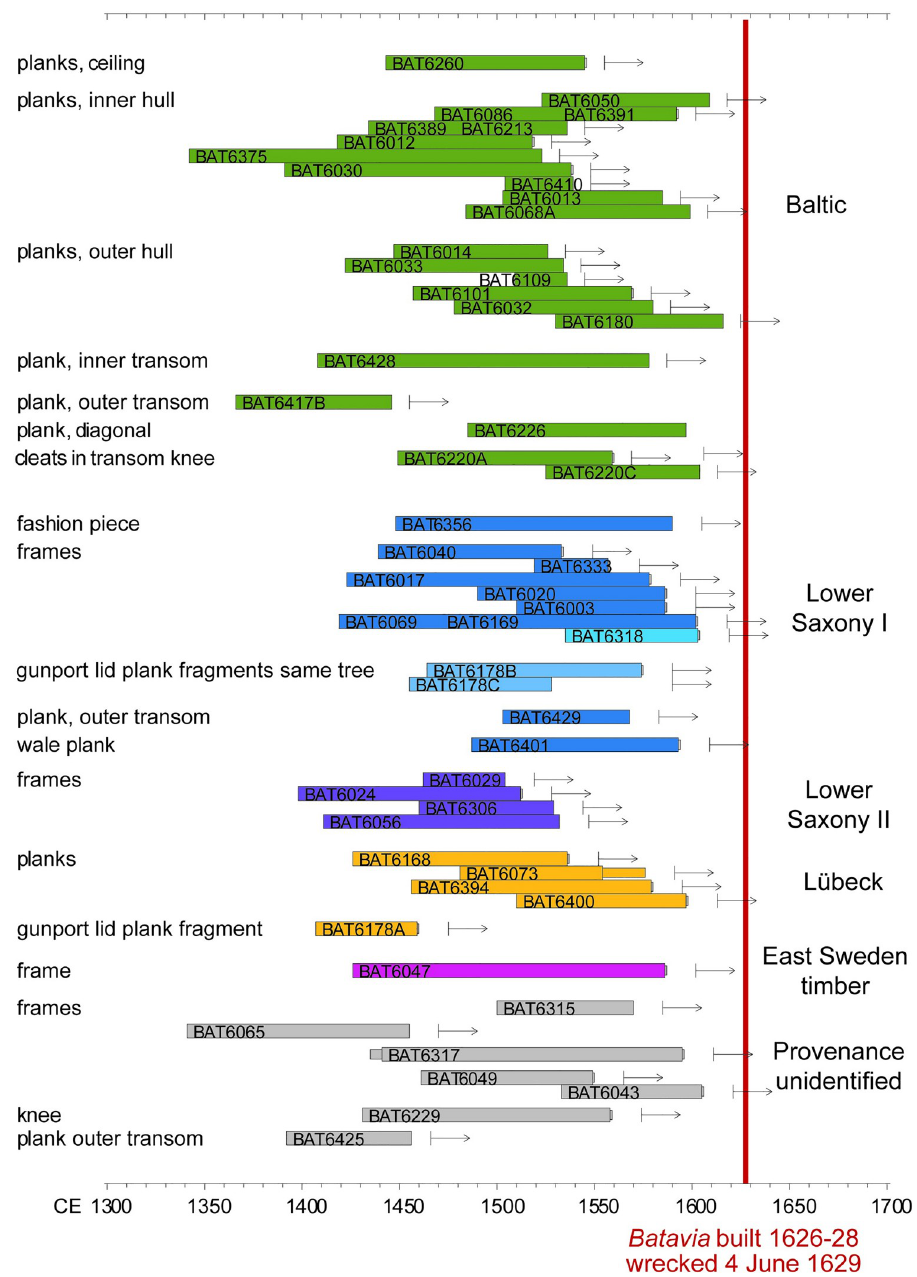
Fig 2. Dendrochronological results. Each bar represents the time span covered by the dated timbers. The bars are coloured according to the dendrochronological groups that have been identified. The red vertical line marks the dating of the building and wrecking of Batavia